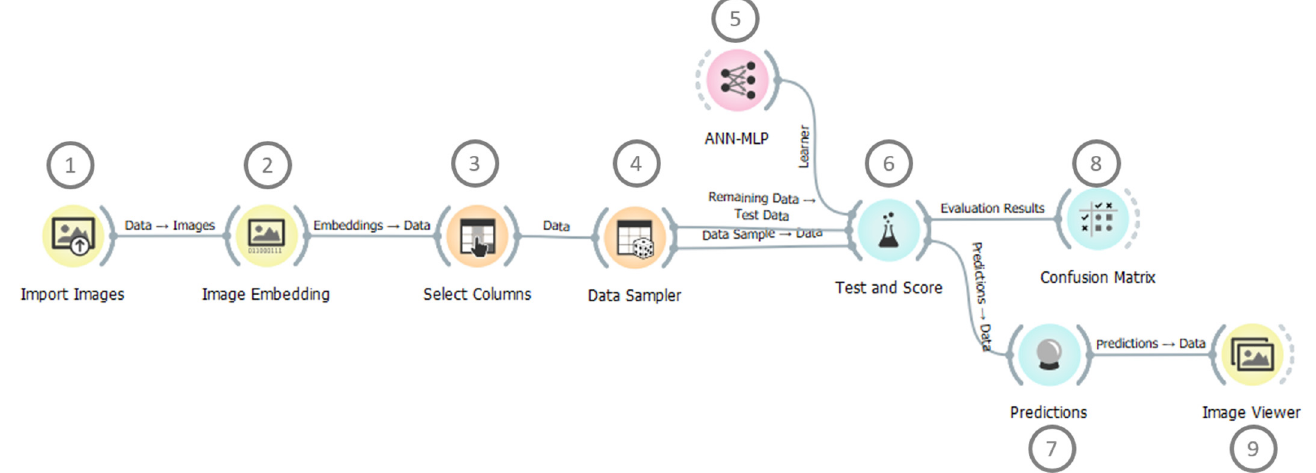
Figure 4. Flowchart showing the steps of the classification test by the Convolutional Neural Networks (CNNs). 1. Import of labeled subimages; 2. Embedding and model application to calculate a feature vector for each image; 3. Selection of columns containing the extracted attributes; 4. Splitting the dataset into training and testing sets; 5. Multilayer Perceptron (MLP) classifier (last fully connected layer); 6. execution of tests on the separate set for this purpose and presentation of the results of the quantitative assessment of the classification; 7. Prediction for each subimage; 8. Generation and presentation of the confusion matrix; 9. Visualization of images by class.